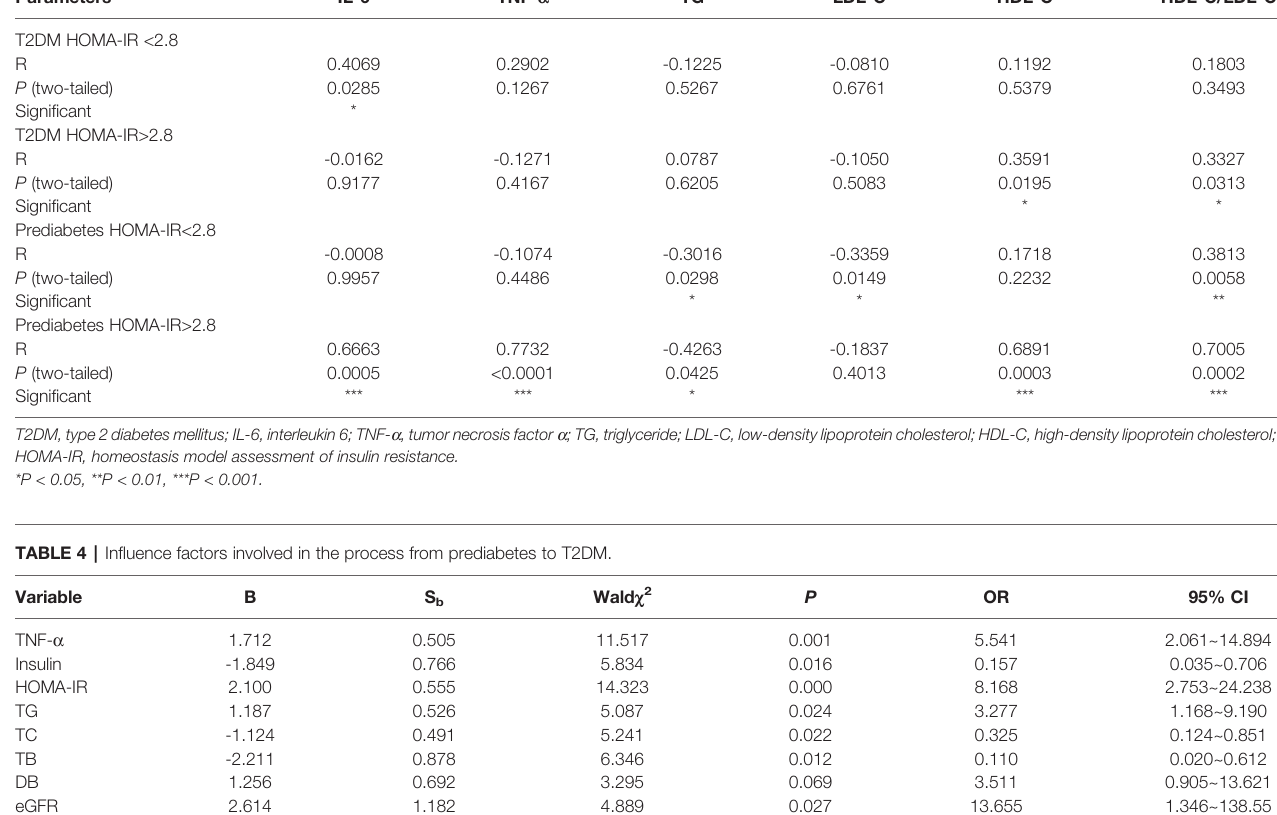
TABLE 3 | Correlation of adiponectin with other indexes of subgroups.